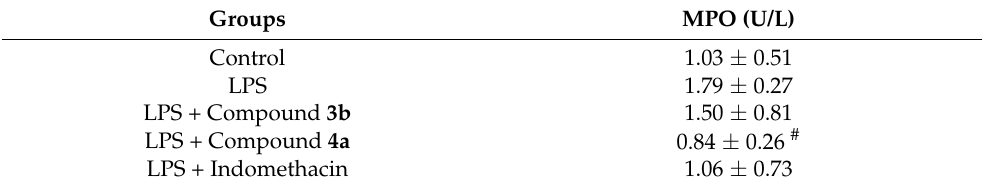
Table 7. Effects of compounds 3b , 4a, and indomethacin on MPO